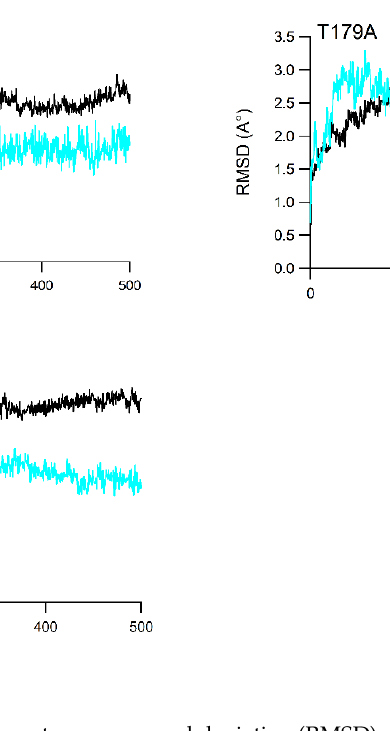
Figure 1. The docked poses of GS − 461203 ( A ) in WT (green), T179A (blue) and M289L (purple), two manganese ions (purple), with the positions of mutated residues; and the chemical structure of the drug ( B ).